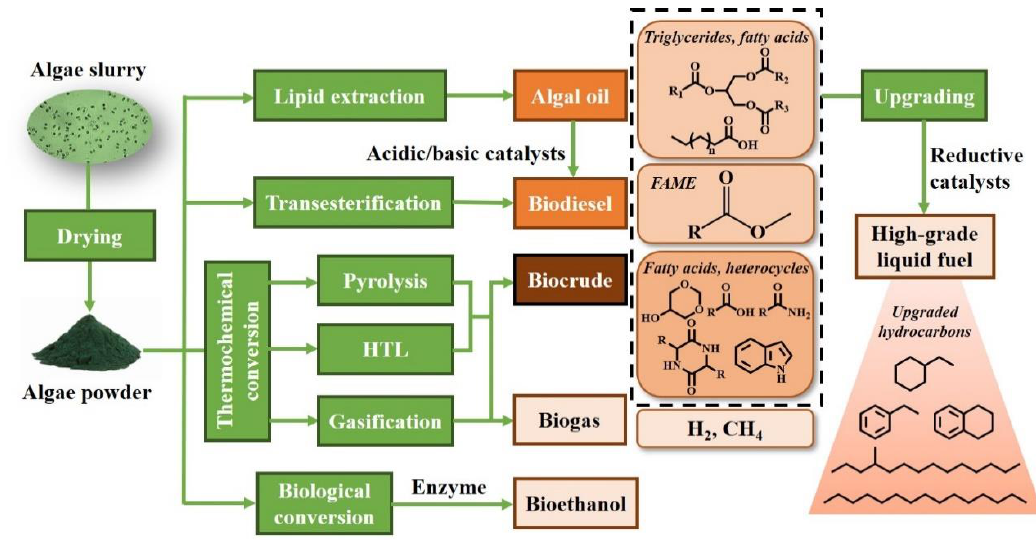
Figure 1. Schematic diagram for conversion of algae into biofuel.